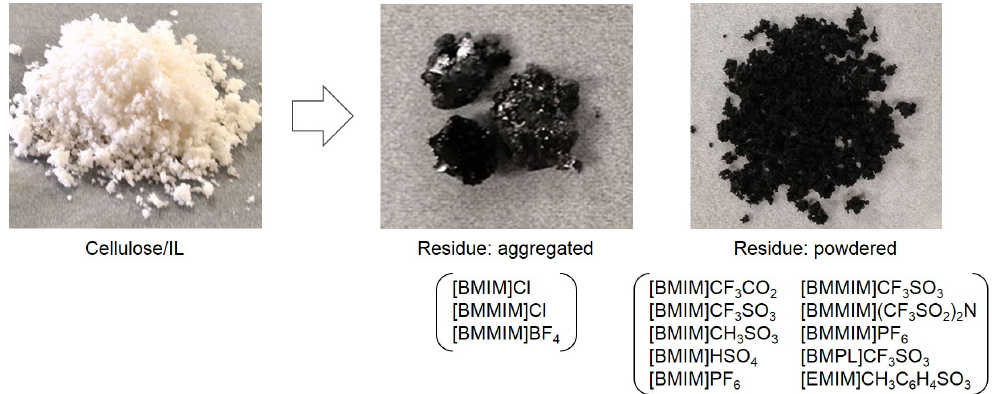
Figure 8. Examples of cellulose/IL mixture and two types of residue (char/IL): aggregated and powdered